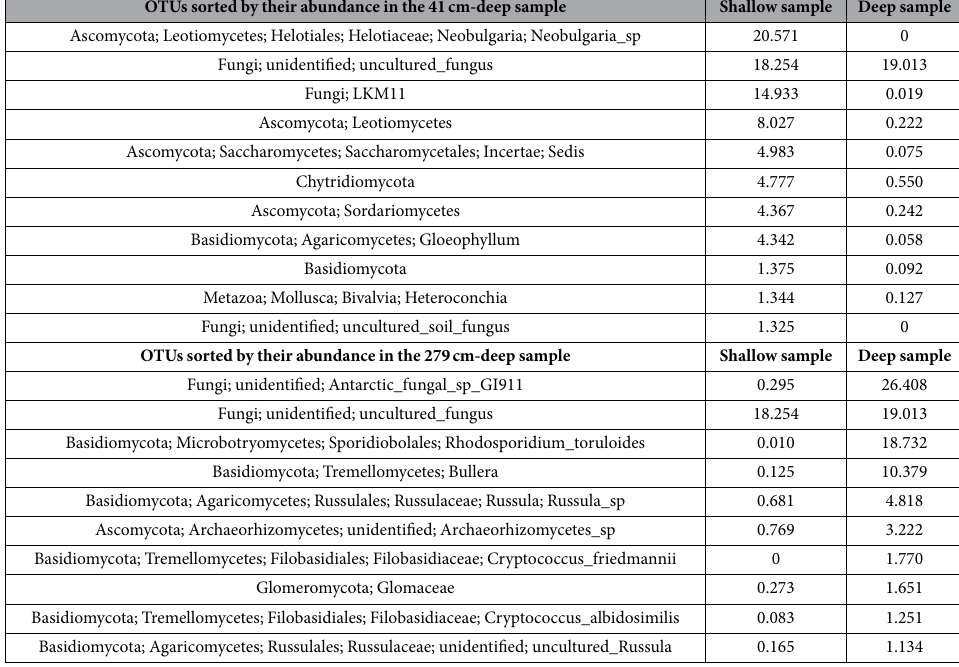
Table 5. Eukaryotic OTUs % at species level (with cutoff > 1%), sorted by decreasing abundance in the 41 cm- deep sample (top part of the table) or in the 279 cm-deep sample (bottom part of the